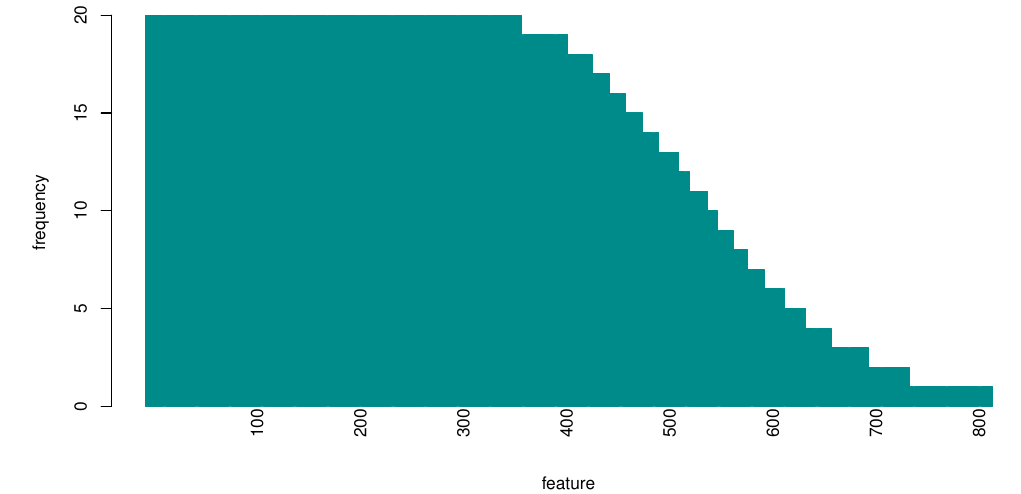
Figure 4. Histogram of the frequency of occurrence of the top 493 genes over 20 repetitions. At each repetition we collected the 493 most important genes; over 20 repetitions we gathered in total around 800 genes, many of which (365) appeared in all 20